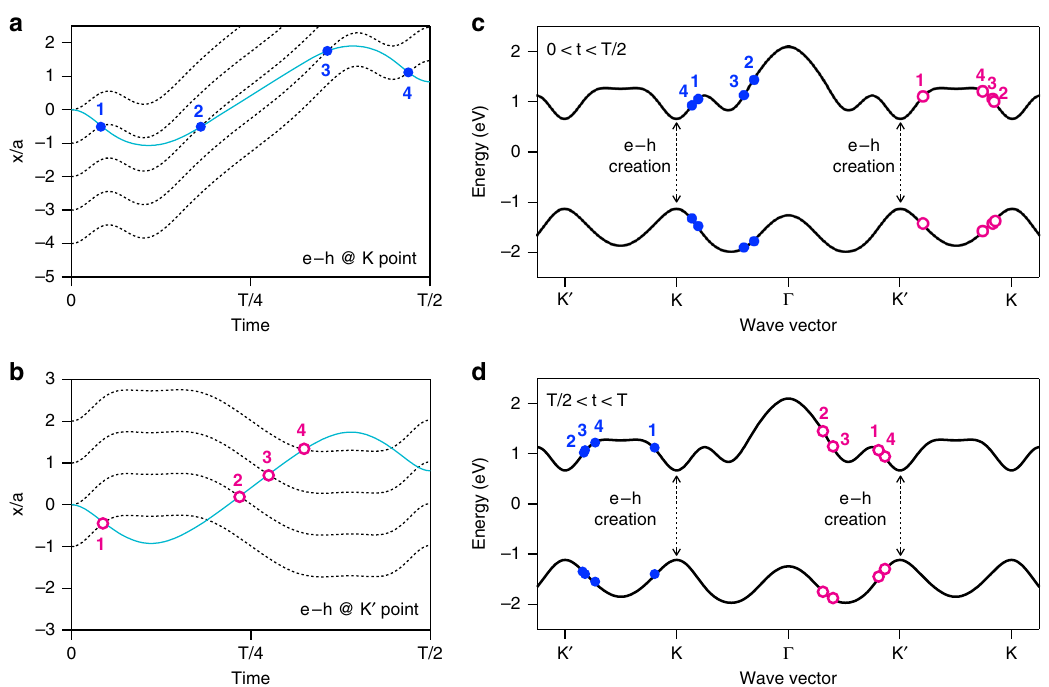
Fig. 4 Semi-classical calculation of electron – hole dynamics in the real and momentum space. a Real space dynamics of carriers generated at t = 0 and the K point under excitation with polarization along zigzag direction. The turquoise curve shows the trajectory of the hole generated at x / a = 0, and the black dashed curves show the electrons generated at x = a ¼ 0 ; (cid:2) 1 ; (cid:2) 2 ; (cid:2) 3 ; (cid:2) 4. The possible recombination paths of the hole and electrons are marked as blue solid circles. b Same as a but for the carriers generated at the K ’ point. The possible recombination paths of the hole and electrons are marked as magenta open circles. c Recombined electron – hole pairs in momentum space generated at t = 0. The electron – hole pairs created at the K ( K ’ ) point are represented as blue solid (magenta open) circles. The labels from 1 to 4 correspond to those in a and b . The asymmetric features of the electron – hole dynamics in the K and K ’ valleys lead to different times and energies of recombination. Only the electron – hole pairs generated at the K point reach the band nesting region. d Same as c but for electron – hole pairs generated at t = T /2. The dynamics in the K and K ’ valleys are reversed from those of t = 0 and show the alternating nature. Only electron – hole pairs generated at the K point reach the band nesting